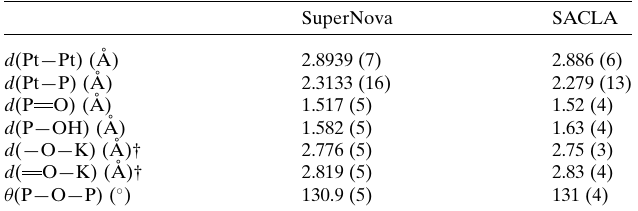
Table 4 Selected bond distances ( d ) and angles ( (cid:5) ) in the K 4 [Pt 2 (P 2 O 5 H 2 ) 4 ] (cid:2) 2H 2 O structure obtained from data measured on an in-house single-crystal diffractometer (SuperNova) and at SACLA.